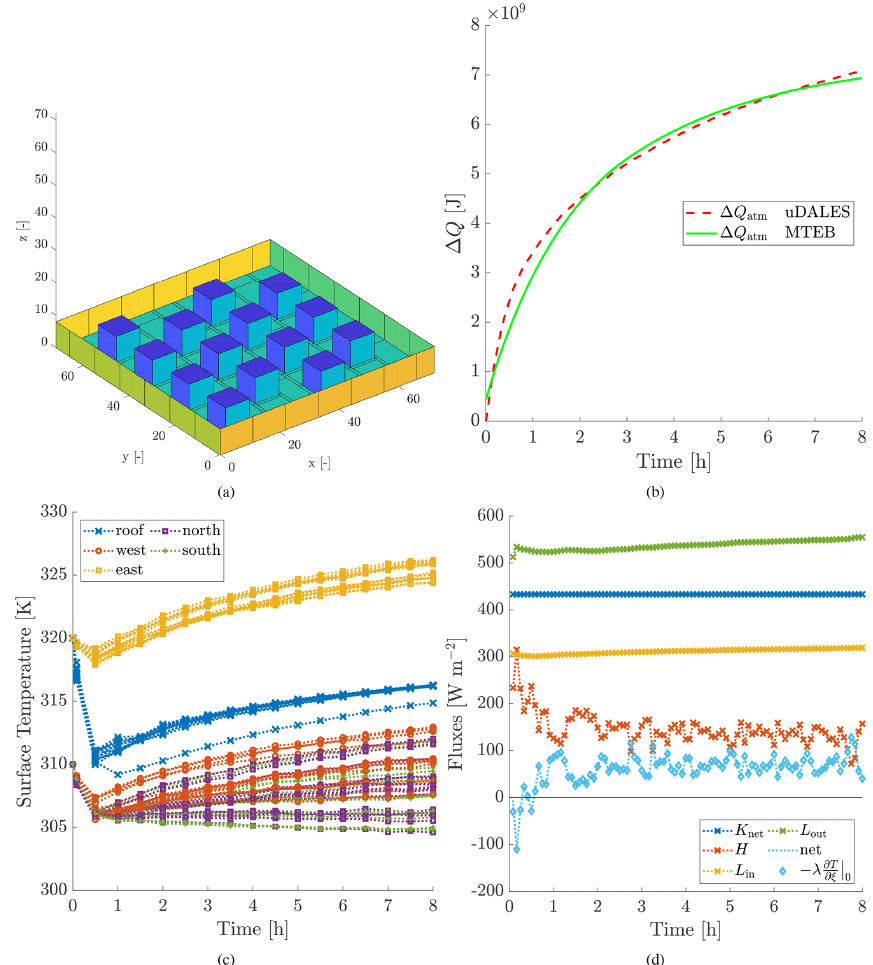
Figure 11. (a) Geometry of the surface energy balance test case. (b) Comparison between uDALES and MTEB of the total energy change in the air over time. (c) Temperature evolution of all building facets. (d) Energy fluxes of a single floor facet.